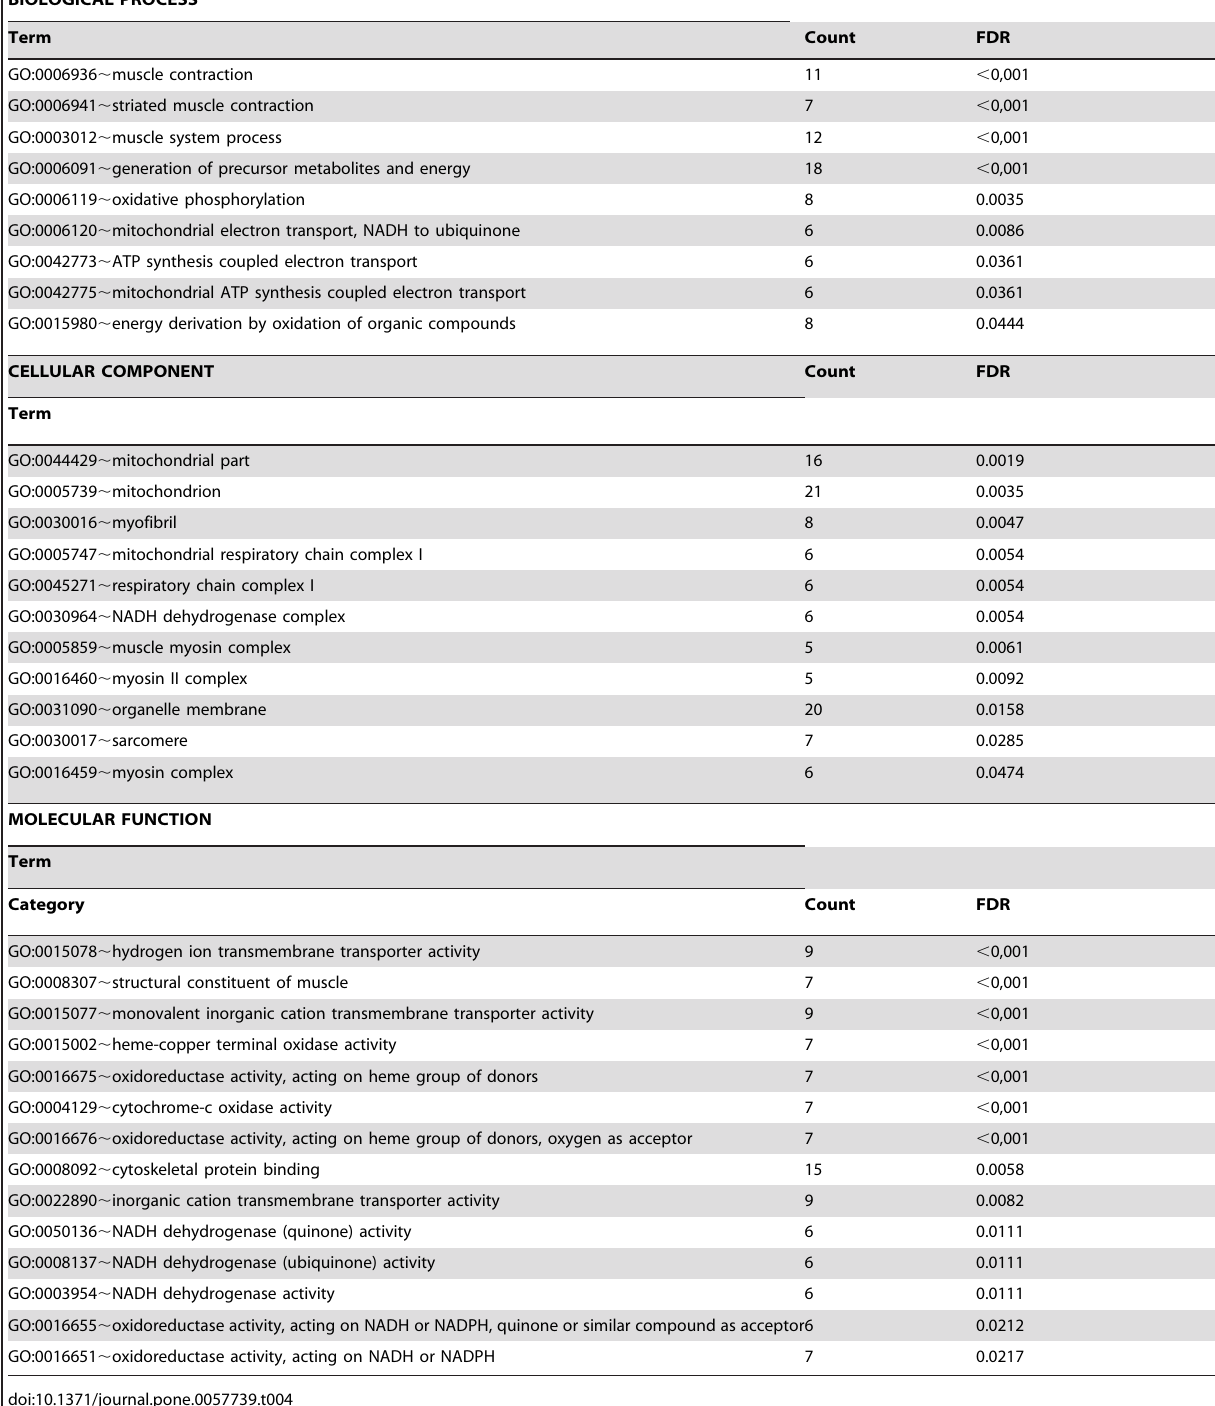
Table 4. DAVID functional